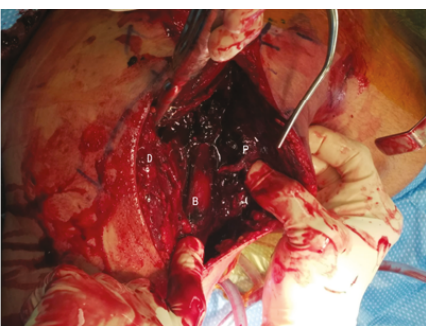
Figure 7: D: deltoid; P: ruptured pectoralis major tendon; B: biceps